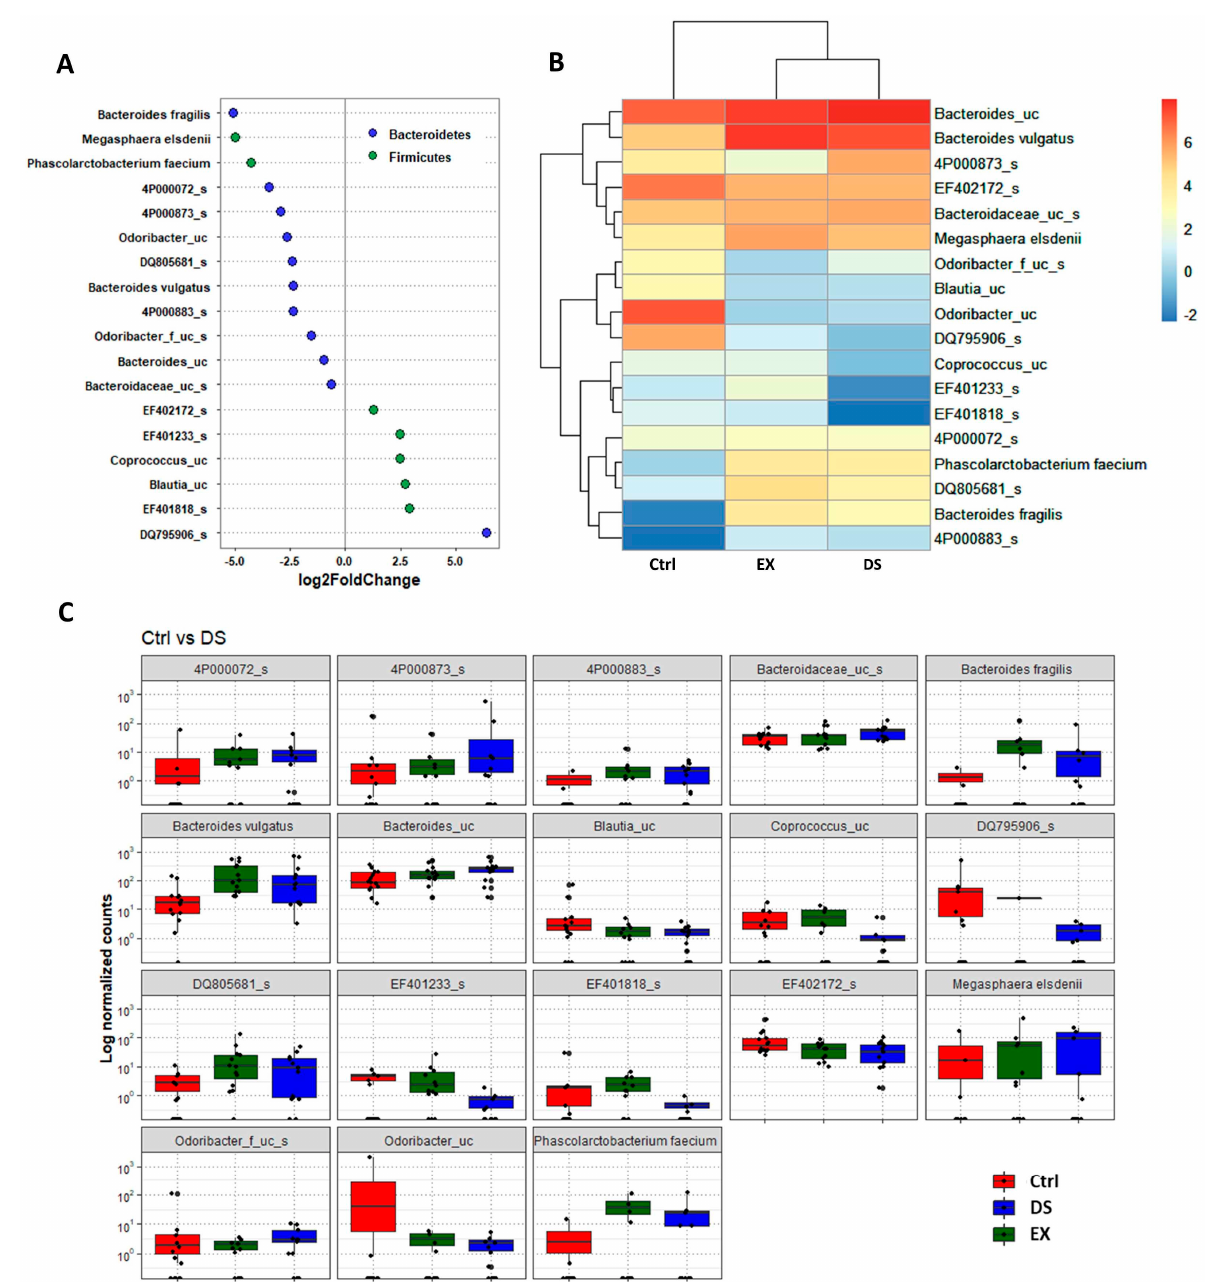
Figure 6. The key taxa changes between Ctrl and DS by differential abundance analysis. ( A ) Log2-fold change in abundance of most abundantly present species in the gut microbiome of the Ctrl and DS groups analyzed by DESeq2 differential abundance analysis. Each point represents a species comparison between two experimental groups. ( B ) Heatmap of most abundantly present species in the Ctrl and DS groups. ( C ) Normalized abundances of 18 significantly different bacterial species of interest that were identified from differential abundance analyses. Boxplots represent normalized count abundances of individual species in each group. p value < 0.05 was considered as significant. Ctrl and DS represent the control and exercise groups, respectively.